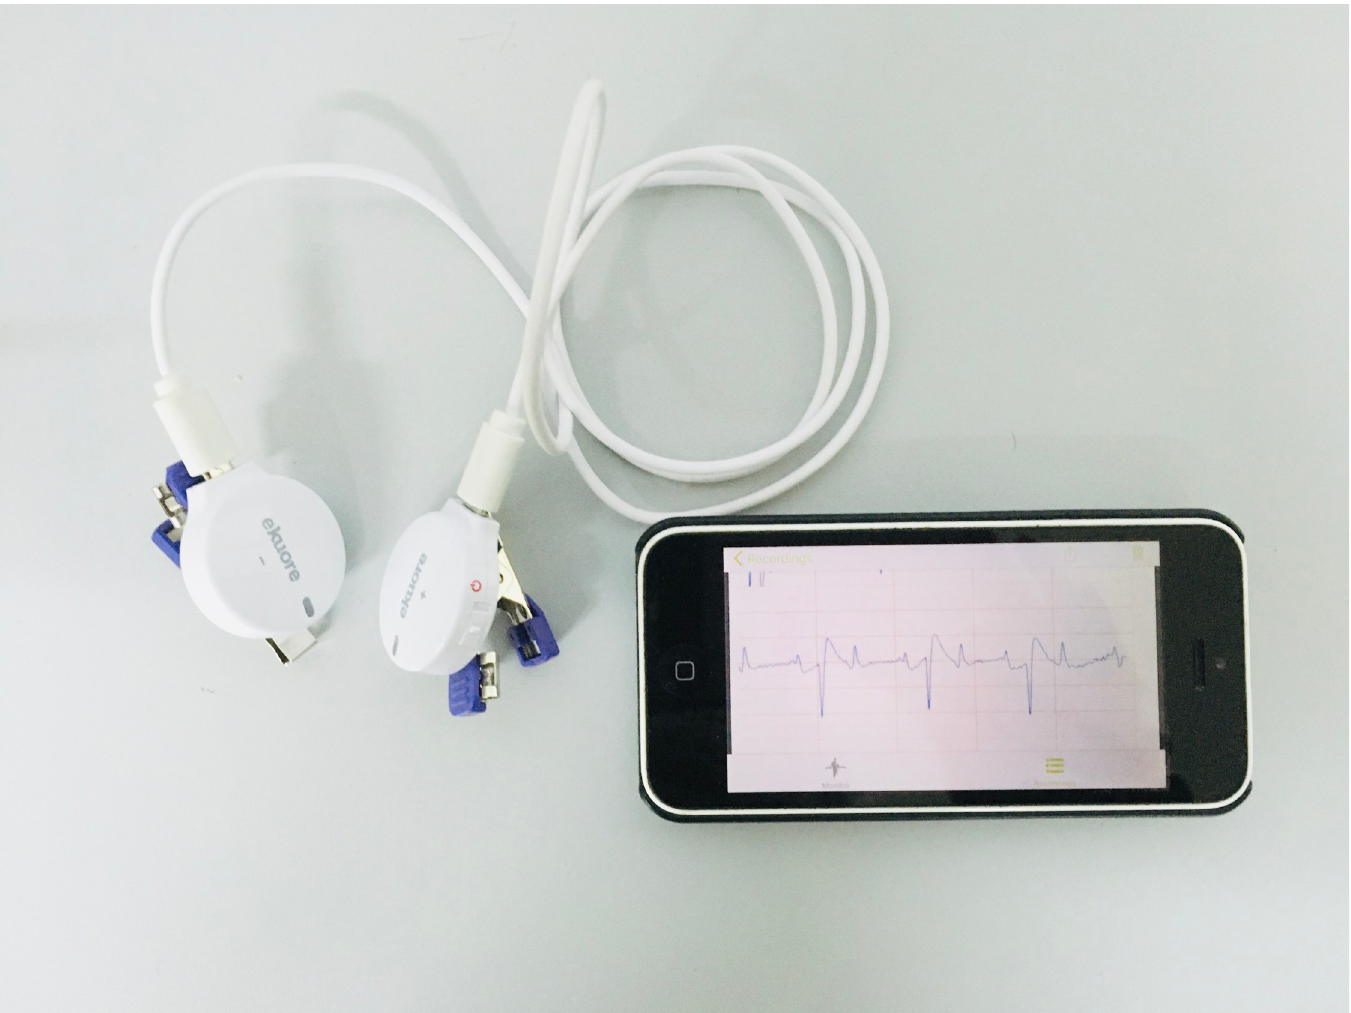
Fig 1. The device consists in two electrodes with clips connected by a micro-USB cable and a smartphone with the app eKuore ECG (Chip Ideas Electronics SL,